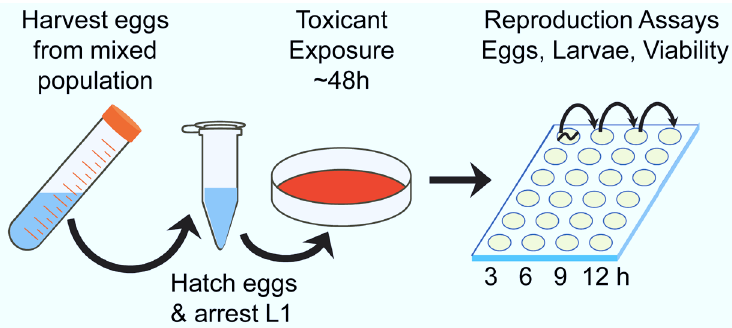
Figure 1. Study experimental design and procedure. An age-synchronized population of C. elegans L1 larvae was exposed to 10 known teratogens at sub-lethal, micromolar concentrations for 48 hours. Gravid adult worms were transferred to pure NGM with bacterial lawns and the number of eggs laid was recorded every 3 hours up to 12 hours. Hatched larvae counted the following